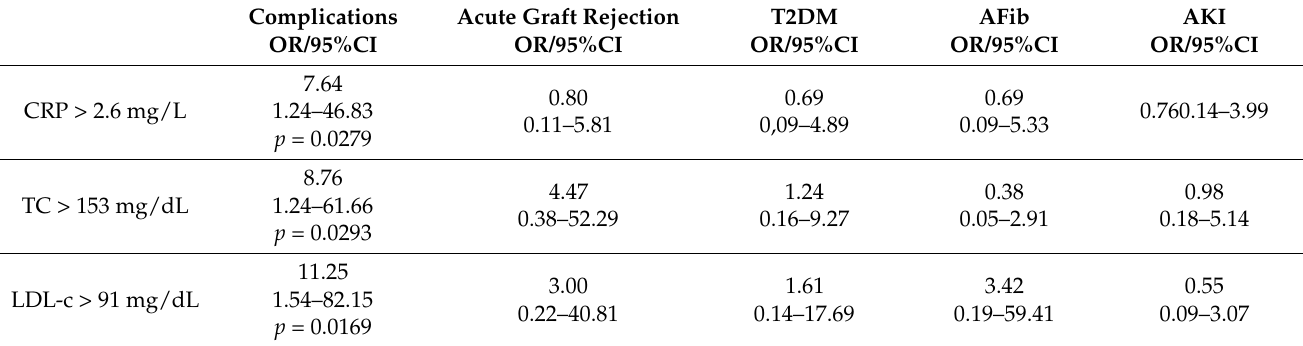
Table 5. Association between the ROC determined cut-off levels of preoperative CRP, TC, and LDL-c and the 2-month presence of postoperative complications/specific type of complications.